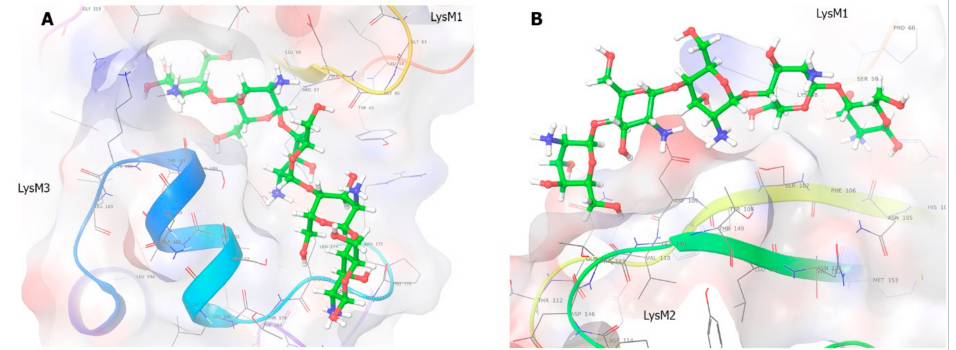
Figure 6. Molecular modeling of Ps LYK9-ECD binding with CO5. ( A ) Binding site 1: This figure shows the computed bonds between Ps LYK9-ECD and CO5 at site 1. CO5 binds Ps LYK9-ECD at site 1 along the groove above the LysM3 domain and partly in the cavity between LysM1 and LysM3. ( B ) Binding site 2: The figure shows the complex-forming bonds at site 2 for a pose with the best score. The complex at site 2 is formed by the protein and the ligand above the groove in the LysM2 and in the cavity between the LysM1 and LysM2 domains. Ligand is attached outwardly at site 2; thus, CO5 is exposed to the solvent more than at site